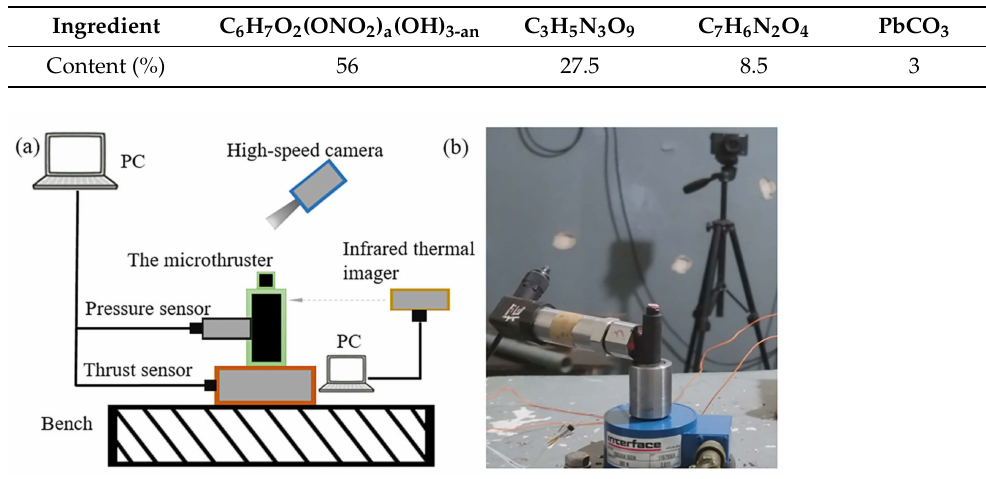
Figure 3. Ablation simulation experimental setup: schematic diagram on the left ( a ) and physical drawing on the right ( b